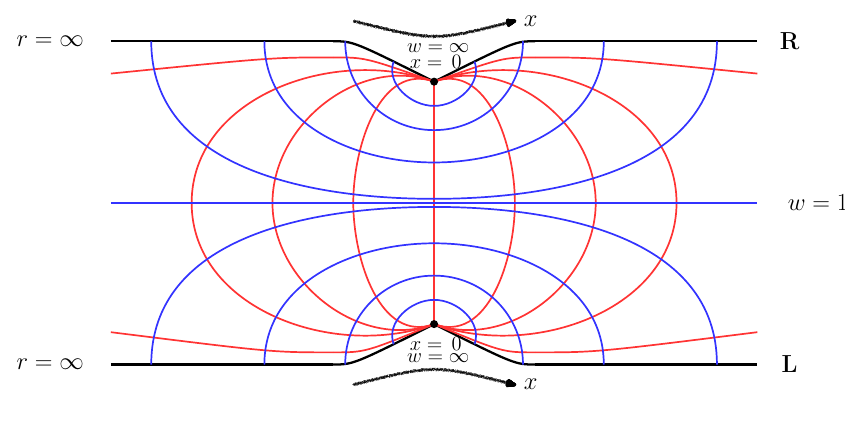
Figure 2 . We draw the constant t section of the two-sided Janus black hole where we show ( (cid:22); w ) together with ( r; x ) coordinates. The middle line with w = 1 represents the horizon. The red lines are representing constant (cid:22) surfaces whereas the blue lines are constant w surfaces. The (cid:22) coordinate is ranged over [ (cid:22) 0 ; (cid:22) 0 ] with (cid:22) 0 > (cid:25)= 2. This leads to the x = 0 angled-joints of the (cid:0) R-L